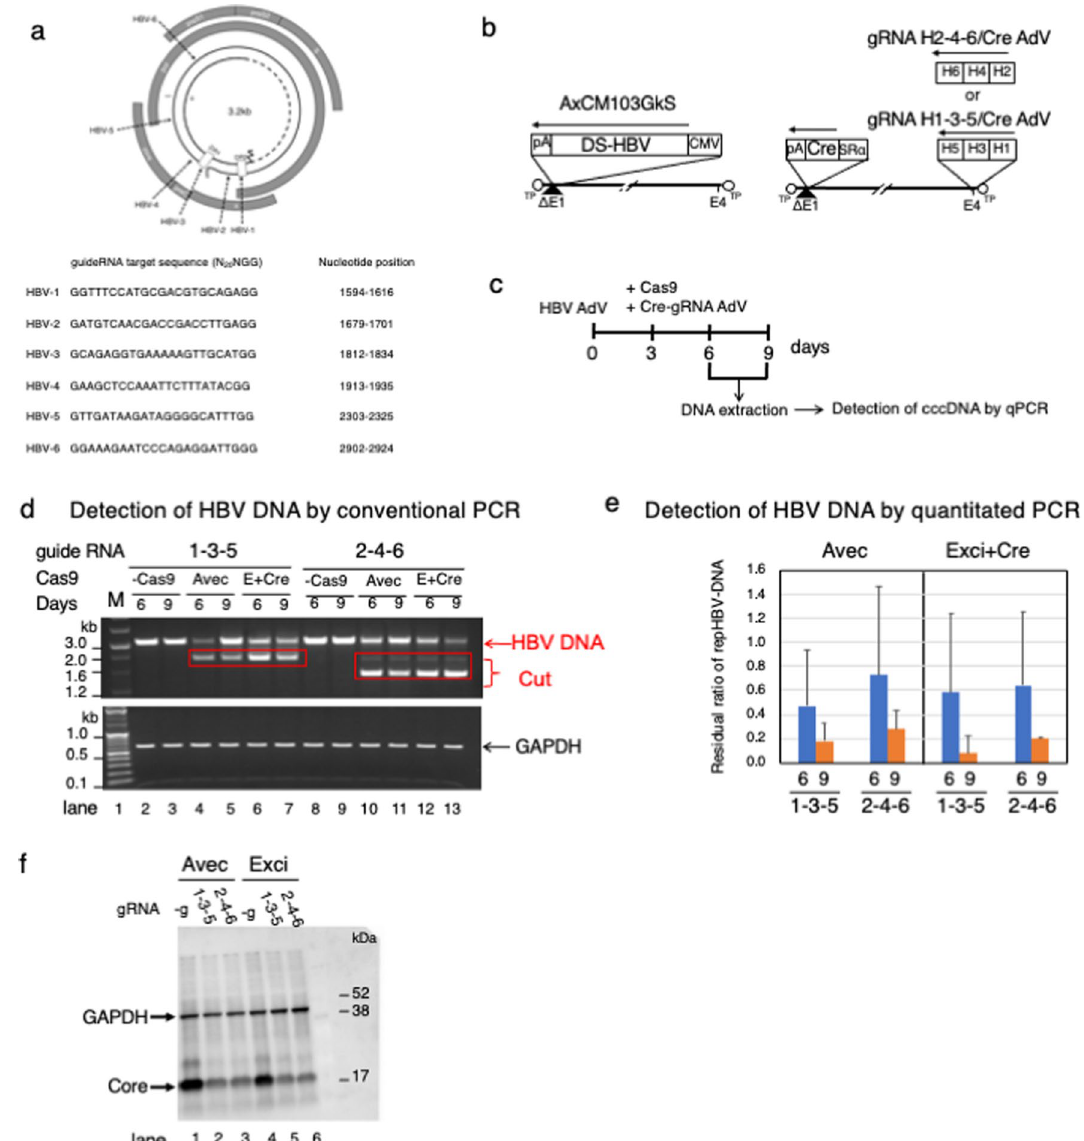
Figure 2. Efficient editing of the HBV genome by Exci-Cas9. ( a ) Position of guide RNA against the HBV genome. ( b ) AdVs for this experiment. Ax-CM103G-kS was used for the HBV103-AdV system. Two kinds of AdVs with three guide RNAs arranged in tandem were used. ( c ) Experimental schema. ( d ) Efficiency of genome editing as detected by conventional PCR using HBV primer sets (Supplementary Table S2) (The raw data was shown as Supplementary Fig. S5). HBV DNA indicates the remaining repHBV-DNA. Cut indicates DNA bands after repHBV-DNA genome editing. ( e ) Estimated remaining repHBV-DNA by TaqMan PCR using HBV primer–probe (Supplementary Table S2). Blue and orange columns show the values at 6 and 9 days after HBV- AdV transduction, respectively. The reproducibility was confirmed in two experiments, and the data of n = 3 was shown. ( f ) Remaining HBV Core protein after genome editing. GAPDH was used as an endogenous Ax-CM103G-kS (Fig. 2b, left), which carries an HBV genome modified to not express the S gene, was used to infect HepG2 cells. The AdVs expressing guide RNAs against the HBV genome and Cre were prepared as gRNA H1-3-5/Cre AdV having gRNA 1, 3, and 5 inserted in tandem, and gRNA H2-4-6/Cre AdV with gRNA 2, 4, and 6 (Fig. 2b, right). Supplementary Fig. S3, because no band was detected 1 day after infection with Ax-CM103G-kS, shows that PCR using HBV primer sets (Supplementary Table S3) did not detect the HBV genome of the AdV, but only detected the HBV genomes generated after HBV replication. The replicated HBV genomes containing cccDNA (named repHBV-DNA) began to be detected on day 2 and were stably detected after 3 days. Therefore, Avec- Cas9 or Exci-Cas9 as Cas9 expression units and AdVs having gRNAs and Cre were used for coinfection at MOI 10 three days after Ax-CM103G-kS infection. Infected cells were harvested, and total DNAs were extracted at 6